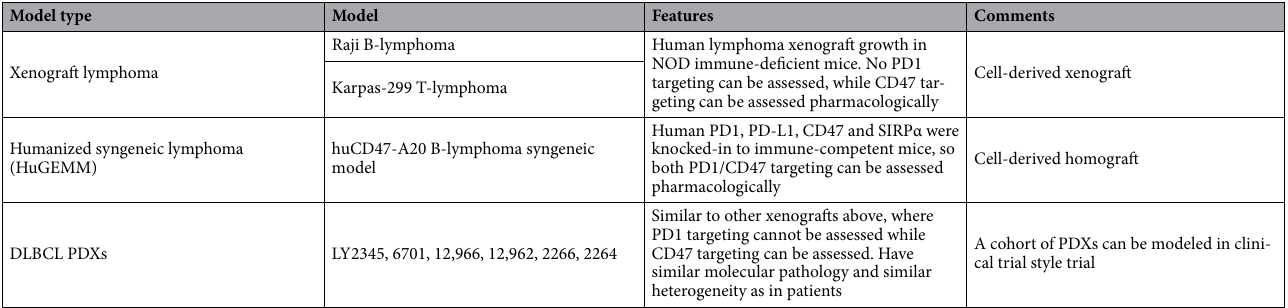
Table 1. Preclinical cancer models used in this